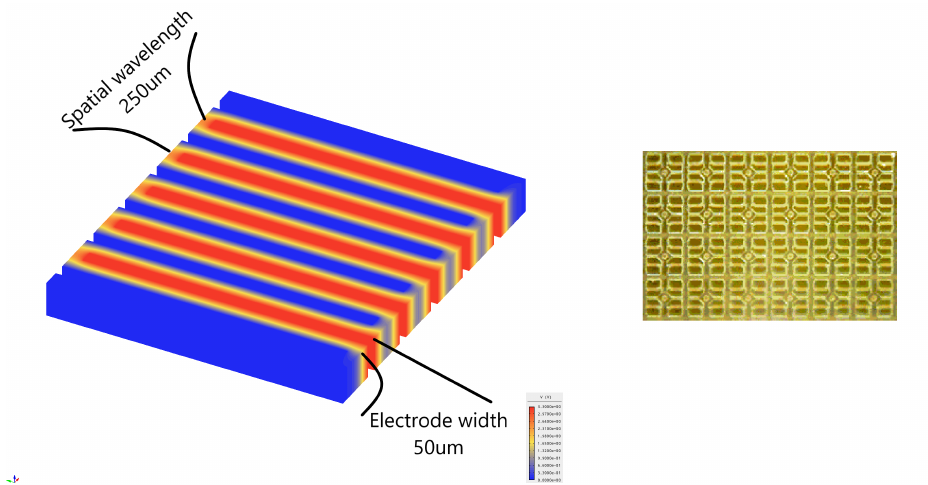
Figure 2. Left , 3D representation of scalar potential for Corneometer’s electrodes as produced using Agros2D [28]. Right , representation of the fingerprint sensor pixels embedded in Epsilon E100